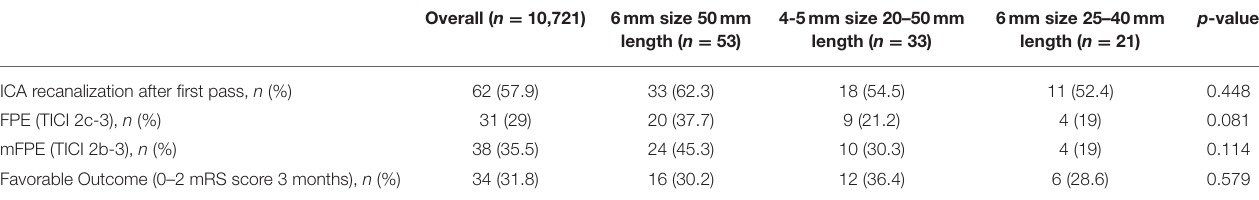
TABLE 3 | Primary endovascular and clinical outcomes related to the stent-retriever size and